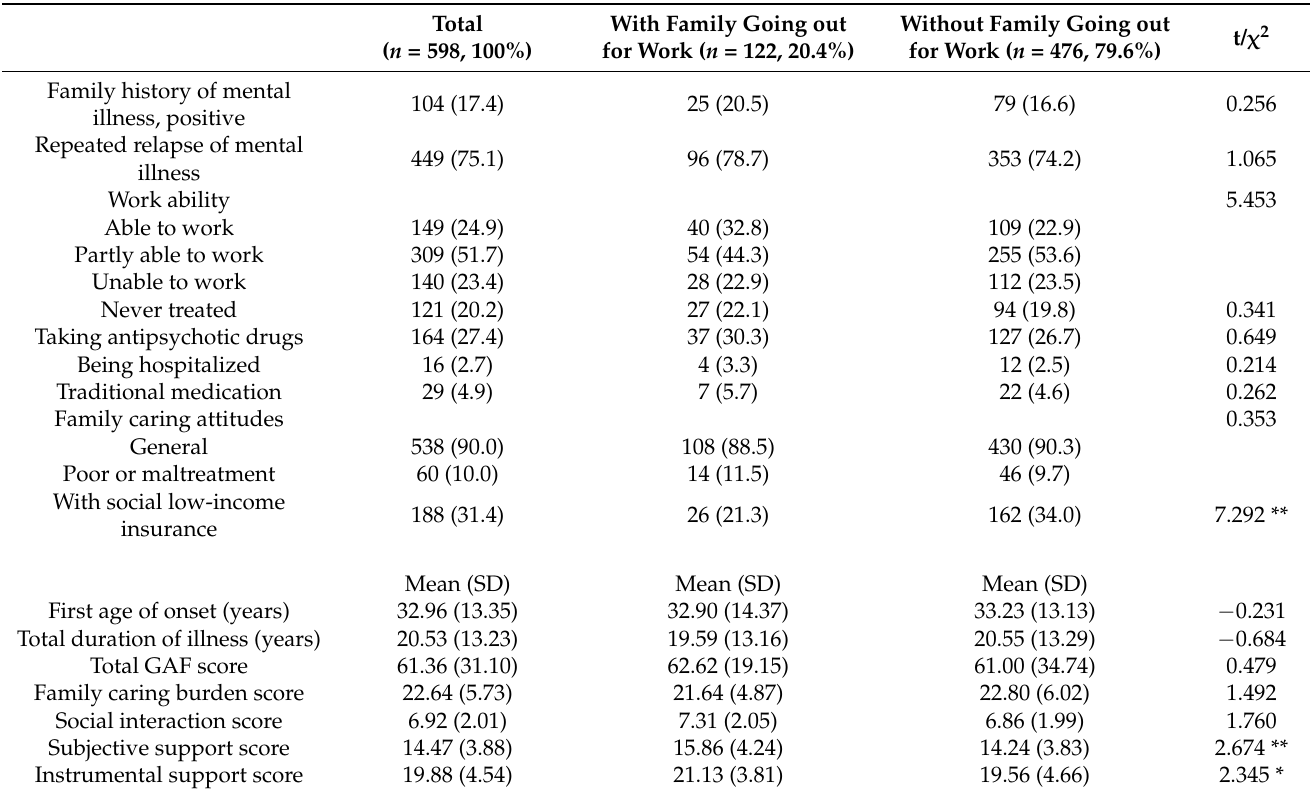
Table 2. Clinical and other characteristics of participants with and without family going out for work.